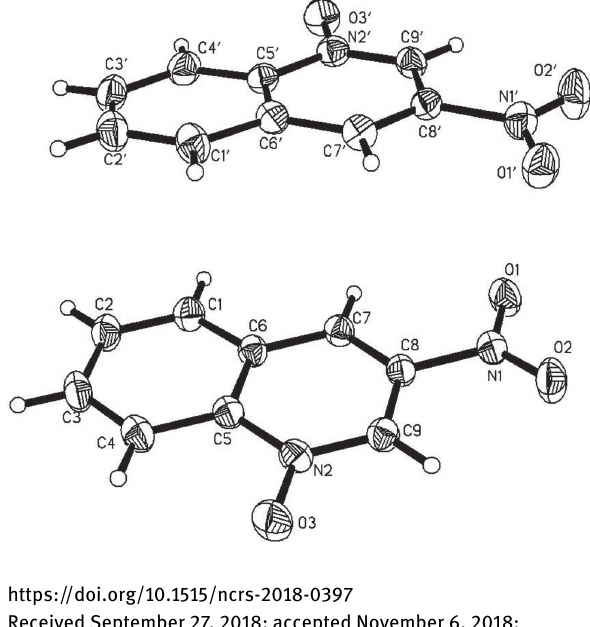
Table 1: Data collection and handling.